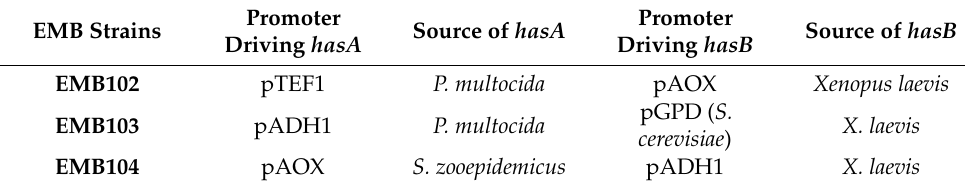
Table 1. Summary of all EMB strains constructed in this study. EMB Strains